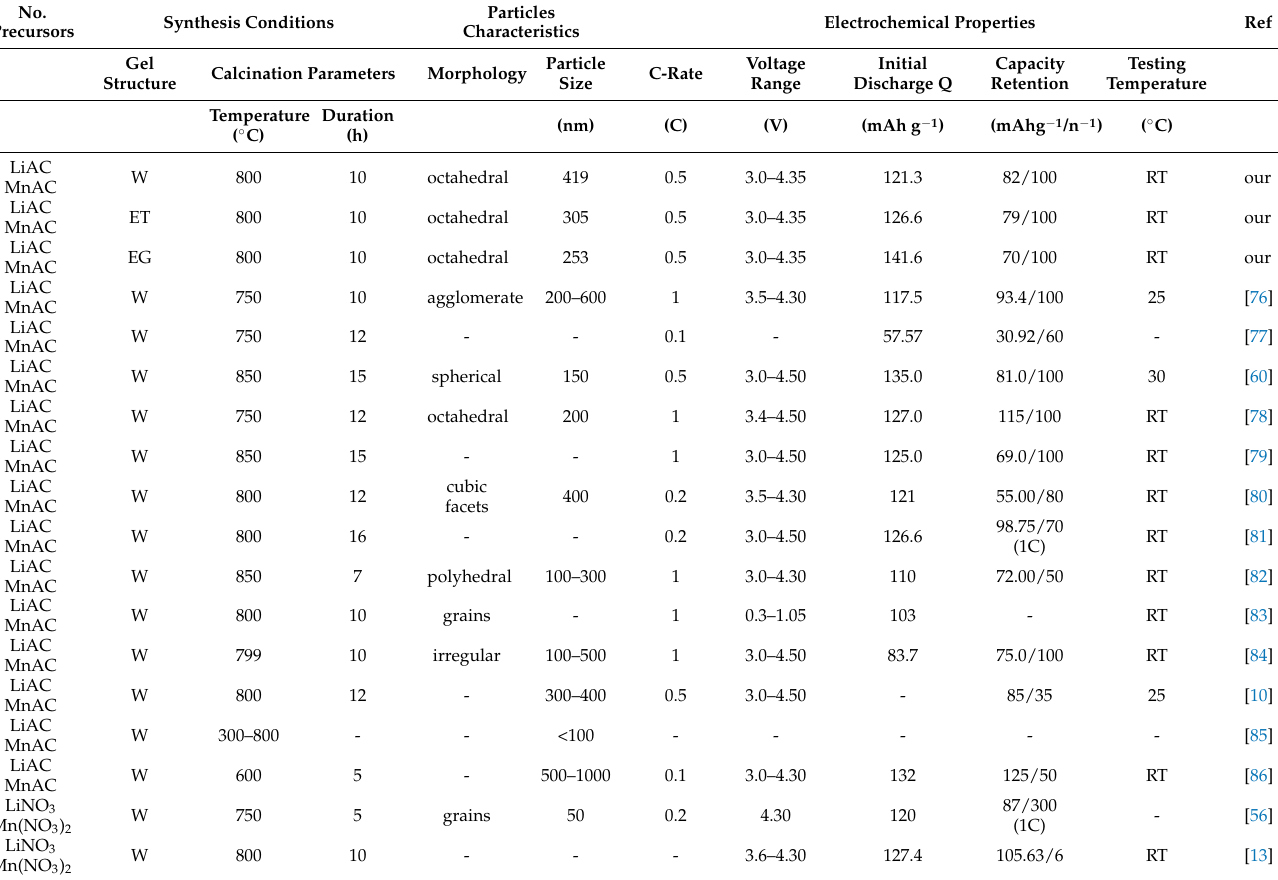
Table A1. LiMn 2 O 4 powder synthesized by a citric acid chelate agent of sol-gel